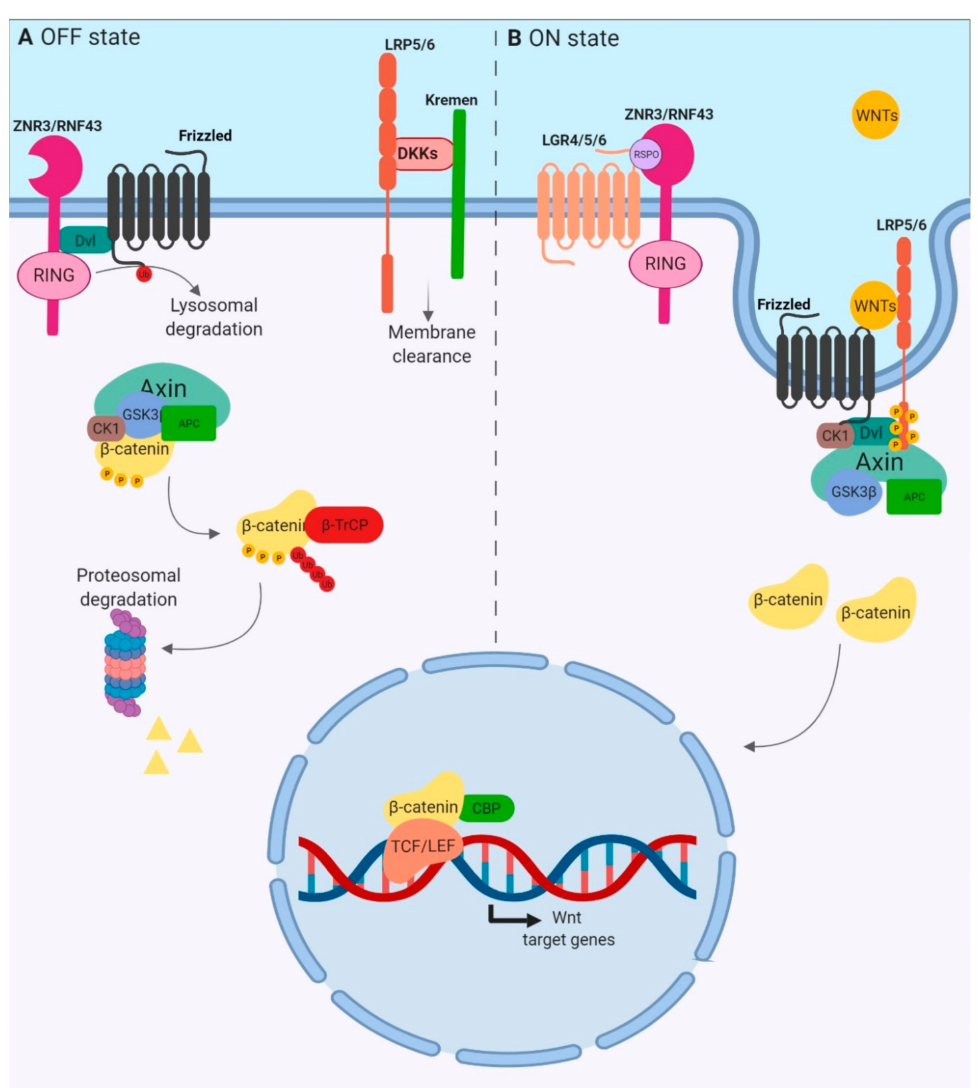
Figure 1. Overview of canonical WNT signaling. ( A ) OFF State. The absence of WNT ligands and the presence of antagonists such as DKK family members are associated with the inactive state of the pathway. The β -catenin destruction complex, formed by the sca ff olding proteins AXIN and APC, and the kinases CK1 α and GSK3, promotes the β -catenin phosphorylation, triggering its ubiquitination by the E3 ubiquitin ligase β -TrCP and its proteosomal degradation. ( B ) ON State. R-spondin (RSPO) and WNT ligands activate the pathway. RSPO binds both the ring finger proteins RNF43 / ZNRF3 and the LGR receptor to form a ternary complex which is rapidly endocytosed. WNT glycoproteins are then able to bind Frizzled and LRP5 / 6 coreceptors, forming the WNT–FZD–LRP5 / 6 trimeric complex which recruits the sca ff old protein Dishevelled (DVL) which itself polymerizes to bind AXIN. This promotes the formation of LRP6 signalosomes in which LRP6 is phosphorylated by CK1 and GSK3 kinases, releasing β -catenin, which accumulates and translocates into the nucleus to form an active transcription complex with TCF / LEF